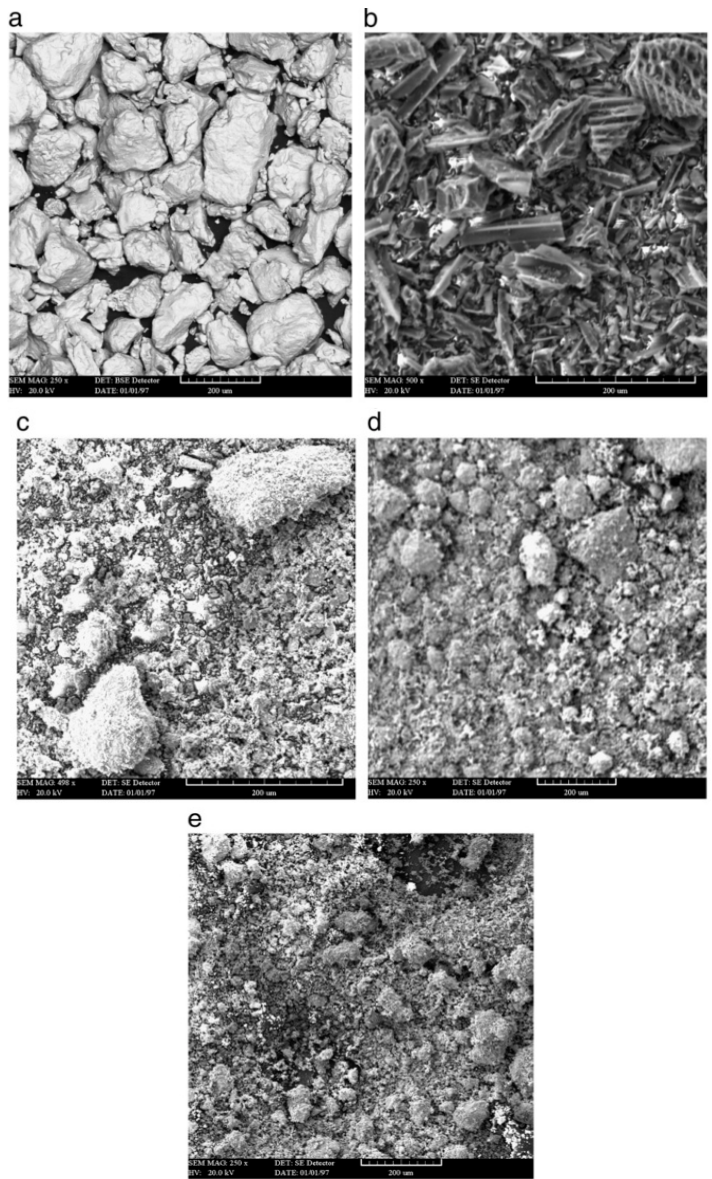
Figure 4. SEM micrographs of ( a ) chromium powders, ( b ) carbon powders, ( c ) Cr 3 C 2 mixture milled for 2 h, ( d ) Cr 3 C 2 mixture milled for 6 h, and ( e ) Cr 3 C 2 mixture milled for 10 h [70]. Reprinted with permission from ref [70]. © 2012 Elsevier.